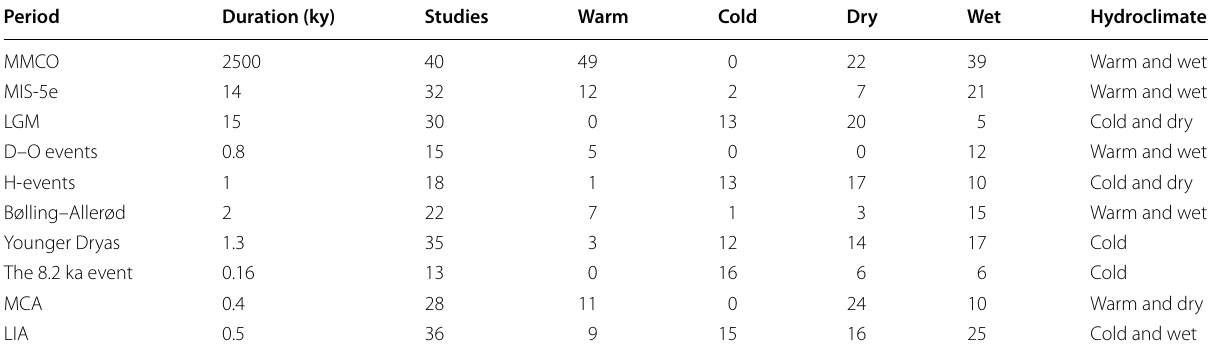
Table 10 Number of studies per period and conditions. The Hydroclimate column describes the most common condition. Average duration is estimated in thousand years